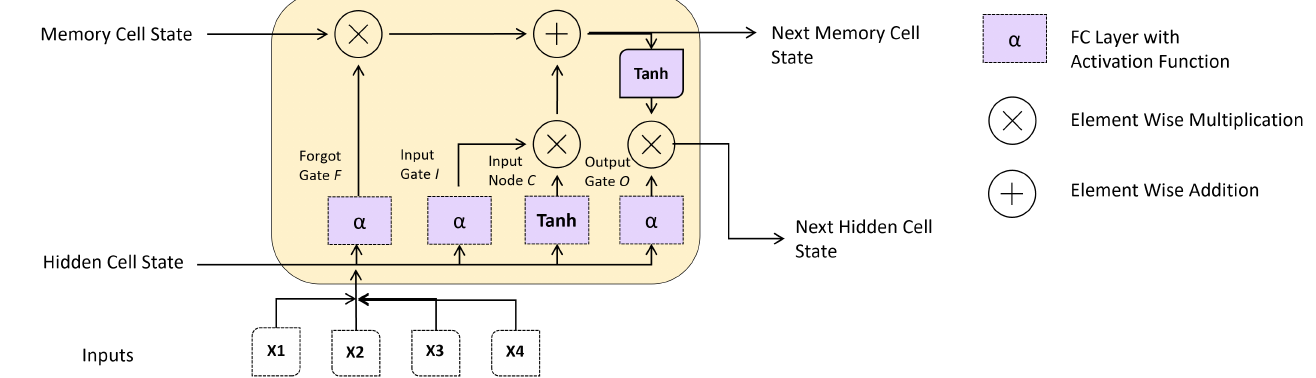
Figure 5. Main components Long Short-Term Memory (LSTM)